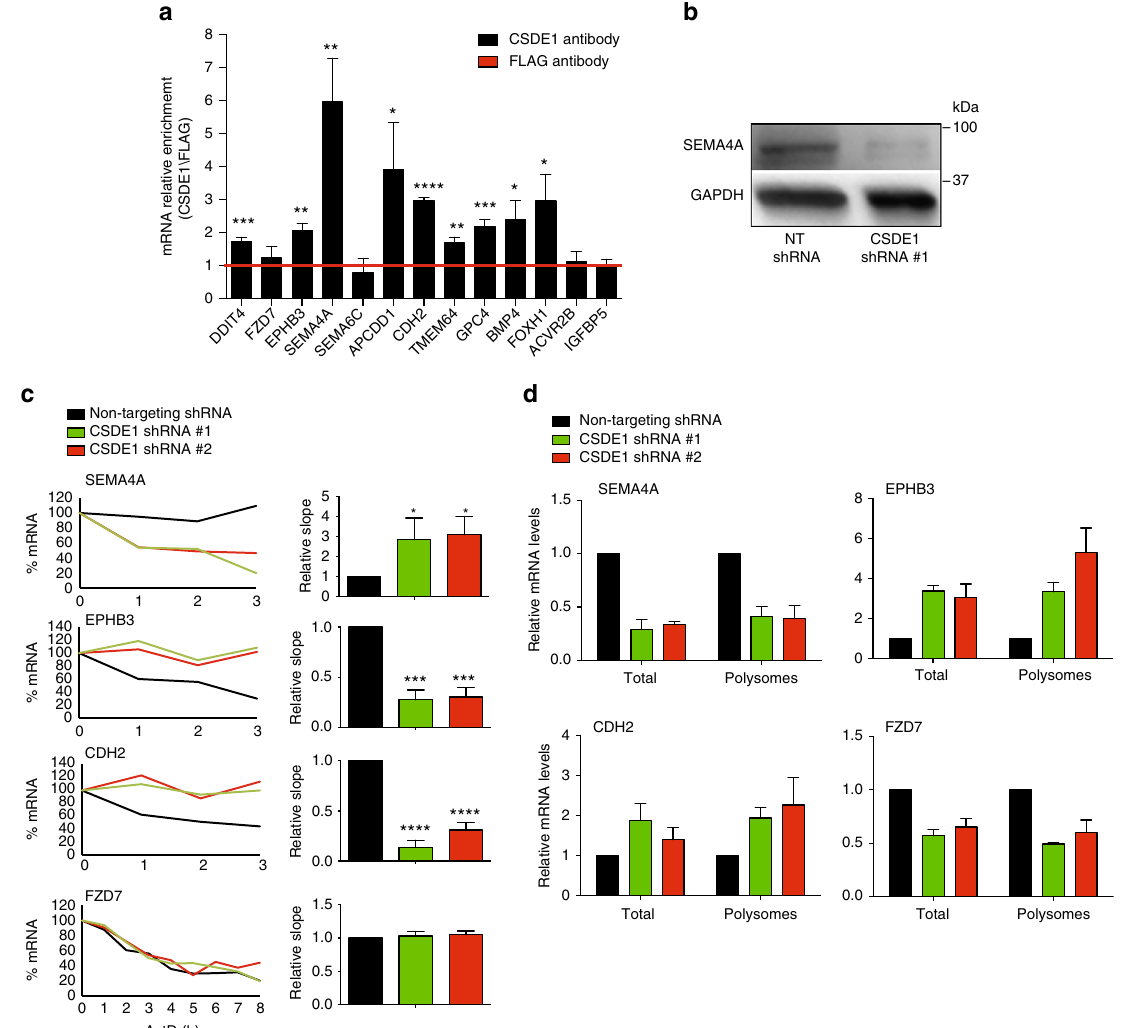
Fig. 10 CSDE1 binds mRNAs involved in neurogenesis and post-transcriptionally regulates their steady-state levels. a RIP with CSDE1 antibody. Quantitative PCR analysis of the indicated genes is expressed as fold enrichment over RIP performed with FLAG control antibody. Graph (relative enrichment to FLAG antibody) represents the mean ± s.e.m. ( n = 4 independent experiments). b Western blot analysis of H9 hESCs with antibody to SEMA4A. GAPDH is the loading control. c mRNA levels were determined after the indicated time of actinomycin D (ActD) treatment (5 μ g ml − 1 ) by qPCR. For each gene, the right graph corresponds to a representative experiment showing the percentage of mRNA relative to time = 0. In the left panel, mRNA degradation is shown as relative slope to non-targeting shRNA hESCs (mean ± s.e.m. of four independent experiments). d Polysome pro fi ling experiments followed by qPCR analysis. Total and polysome fractions mRNA levels are expressed as relative values to total and polysome fractions of NT shRNA hESCs, respectively. Graph represents the mean ± s.e.m. ( n = 4 independent experiments). No further changes in SEMA4A , EPHB3 , CDH2 , and FZD7 were observed in polysome fractions compared with total cell extracts. In a and c the statistical comparisons were made by Student ’ s t-test for unpaired samples. In d the statistical comparisons were made by Student ’ s t -test for paired samples (the mRNA polysome fraction was paired to its corresponding total mRNA in each independent experiment). P -value: *( P < 0.05), **( P < 0.01), ***( P < 0.001), **** ( P <